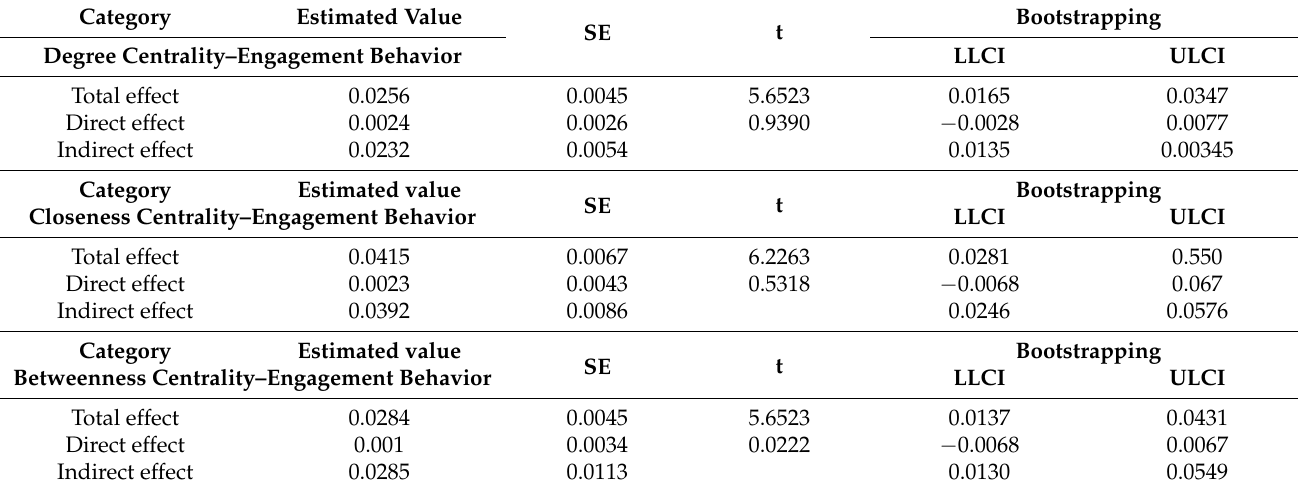
Table 8. Test for intermediary effects of behavioral willingness.